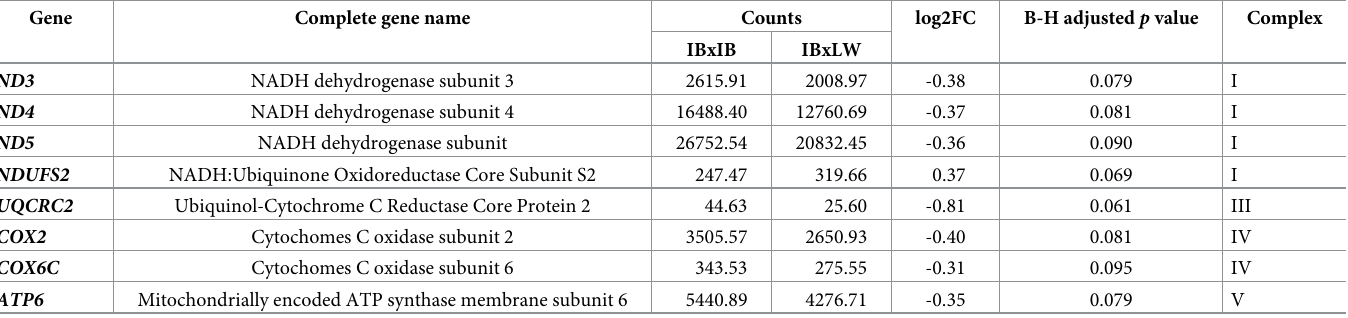
Table 8. Significant (B-H adjusted p value < 0.1) differentially expressed genes, observed in 60 days-old pure Iberians (IBxIB) and Iberian x Large White crossbreds pigs (IBxLW) males, related to mitochondrial functions and the respiratory chain complex they belong to.